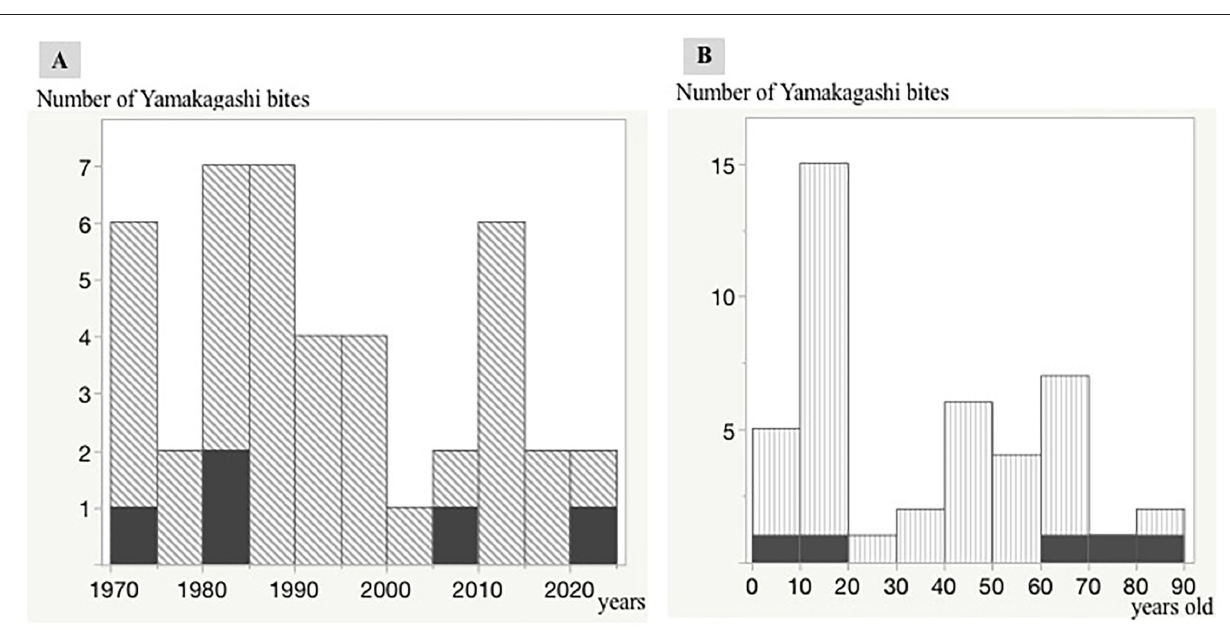
FIGURE 2 | Distribution of R. tigrinus bites in Japan. Trends in R. tigrinus bites over the last 50 years. The black regions indicate fatal cases. A single vertical bar indicates a 5-year period (1970–1974, 1975–1979, 1980–1984, 1985–1999, 2000–2004, 2005–2009, 2010–2014, 2015–2019, and 2020). Relationship between age and number of R. tigrinus bite cases. The black regions indicate fatal cases. A single vertical bar indicates a 10-year period (0–10, 11–20, 21–30, 31–40, 41–50, 51–60, 61–70, 71–80, and 81–90). (A,B) Number of Yamakagashi